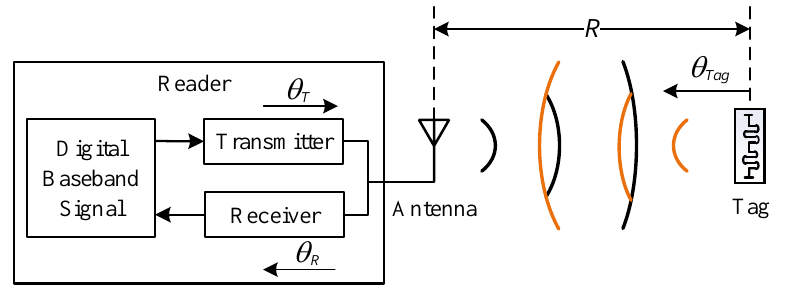
Figure 1. RFID system